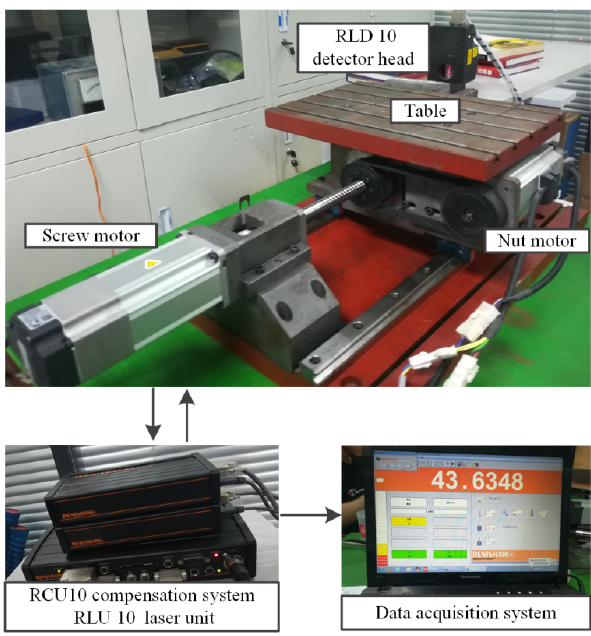
Figure 5. Experimental setup device.